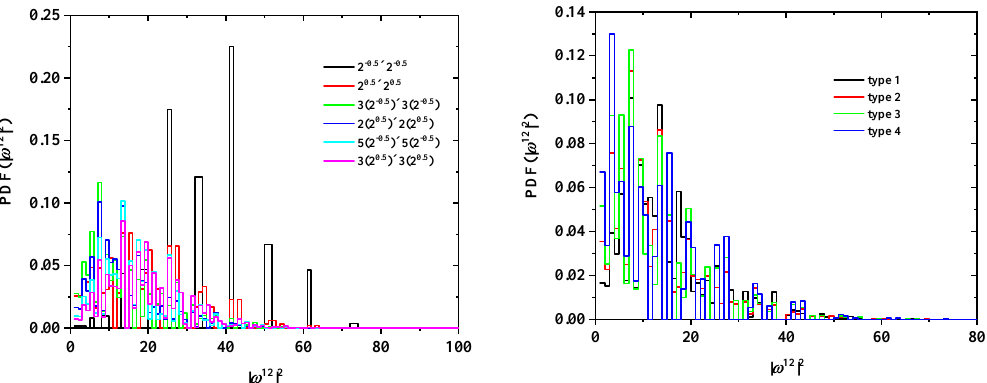
(cid:12) (cid:12) 2 for SAWs of fixed length N = 12 on restricted (cid:12) ω 12 (cid:12)